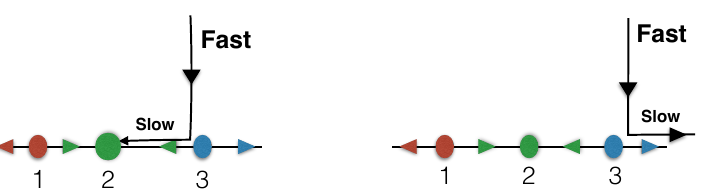
Figure 3. In this (cid:12)gure we depict two di(cid:11)erent classes of (cid:13)ows. The horizontal axis is x 6 , and the vertical axis depicts the other parameters in the SUSY (cid:13)ow. The (cid:12)gure on the left, relevant for small (cid:21) B , shows a fast (cid:13)ow arriving between the second and third (cid:12)xed points, and a subsequent j j slow (cid:13)ow ending up in the second (attractive) quasi-bosonic (cid:12)xed point. The (cid:12)gure on the right, relevant for large (cid:21) B , shows a fast (cid:13)ow arriving at a value of x 6 larger than the third (cid:12)xed point, j j and a subsequent slow (cid:13)ow driving x 6 to